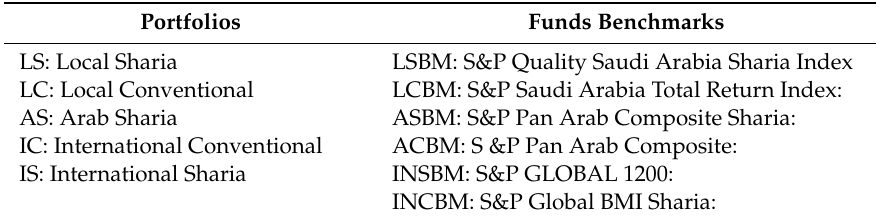
Table 1. Descriptive portfolios and